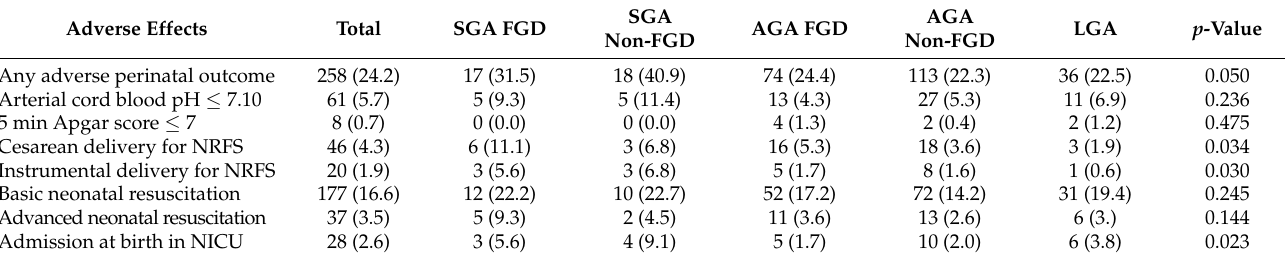
Table 2. Percentage of adverse perinatal outcomes (APOs) in the study groups and the differences between them. Data are reported as n (%). AGA FGD: appropriate for gestational age with fetal growth detention; AGA non-FGD: appropriate for gestational age without fetal growth detention; LGA: large for gestational age; NICU: neonatal intensive care unit; NRFS: non-reassuring fetal status; SGA FGD: small for gestational age with fetal growth detention; SGA non-FGD: small for gestational age without fetal growth detention.